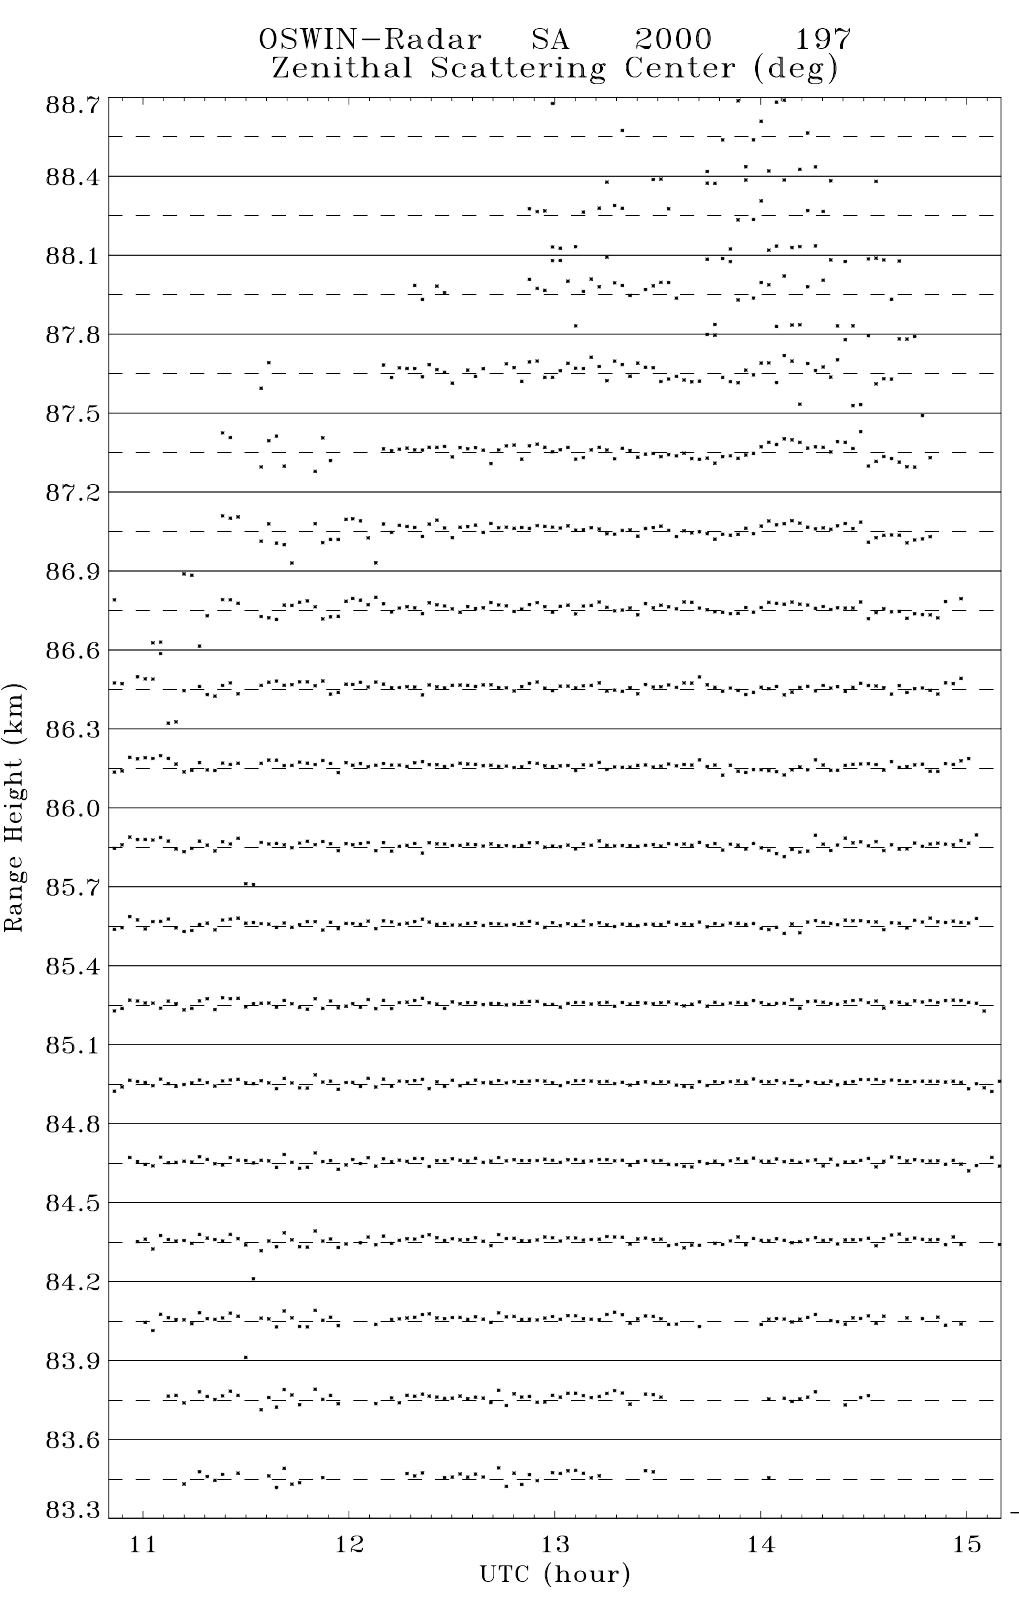
Fig. 8. Height-time variations of the off-zenith angles for the single-scattering-center events, observed by the SA mode. Time resolution is 16 s. The two numbers at the right end of the first gate indicate the angle range in